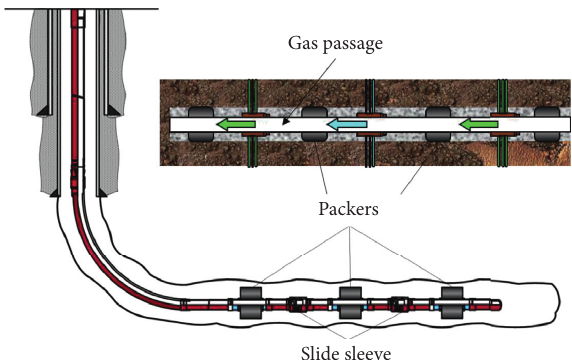
Figure 1: Work mechanical of packer